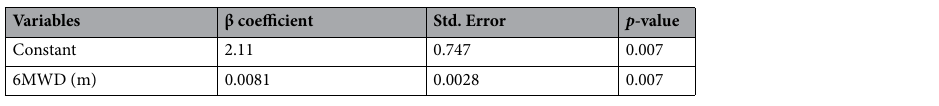
Table 3. Linear regression model between exercise capacity and FMD (%). Adjusted R 2 = 0.15; F = 8.04 (p =